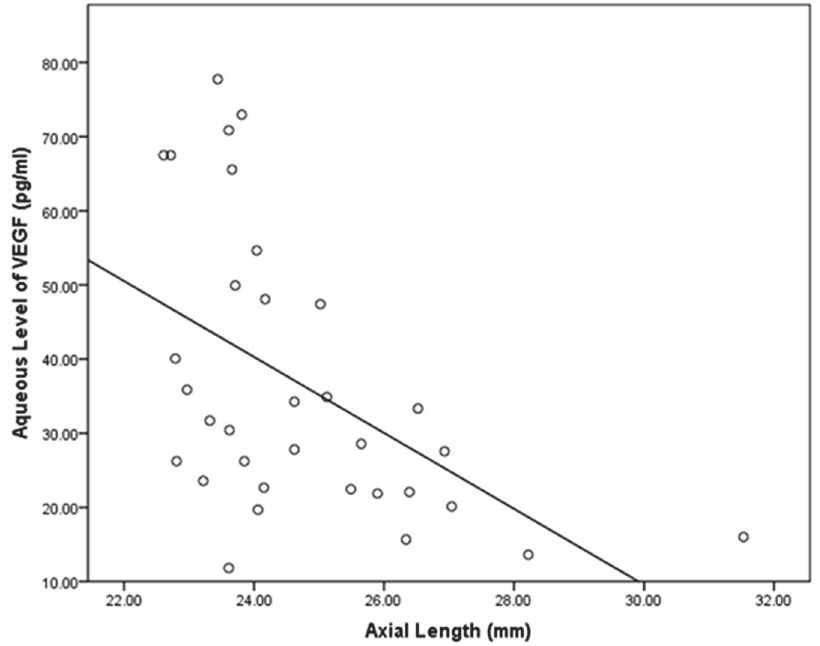
Fig 1. Scattergrams showing the associations between axial length and the concentrations of vascular endothelial growth factor (VEGF) in the aqueous humour of patients without retinal diseases and undergoing routine cataract